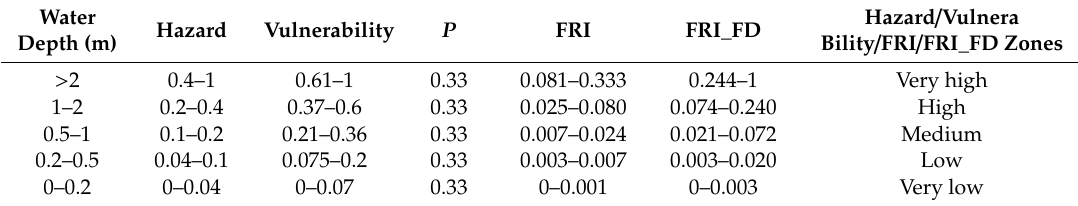
Table 2. Flood risk